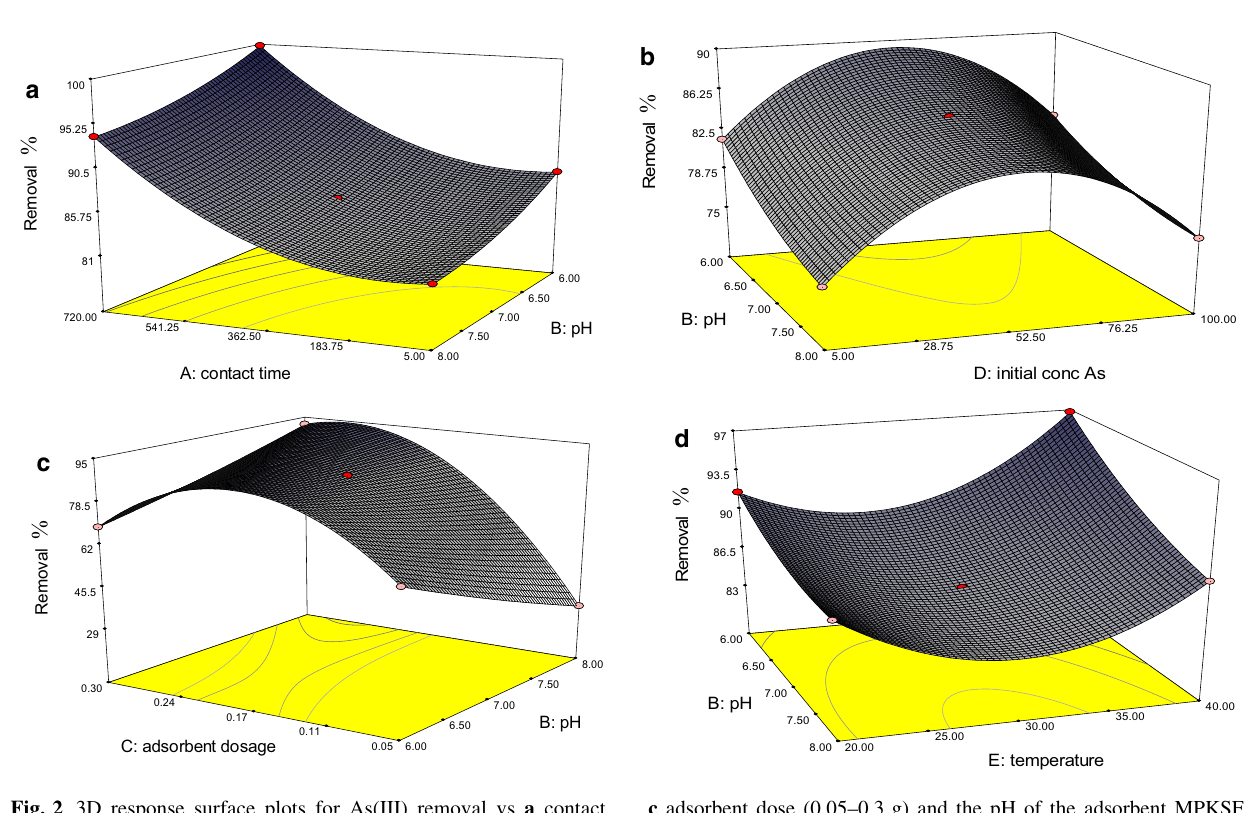
Fig. 2 3D response surface plots for As(III) removal vs a contact time (5–720 min) and the pH of the adsorbent MPKSF suspension (6–8); b initial As concentration (5–100 l g L - 1 ) and pH (6–8); presented. From the responses, the lower value of As(III) residual indicates a higher percentage of removal as given by Eq. (5):